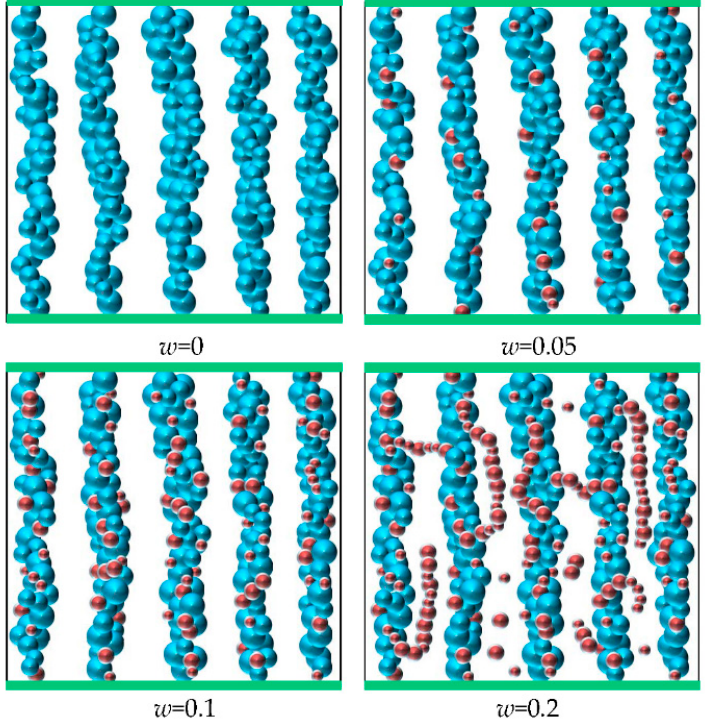
Figure 3. The magneto-induced microstructures with w = 0, 0.05, 0.1, and 0.2, respectively. The larger blue balls denote the CI particles and the red balls denote the Fe 3 O 4 particles.